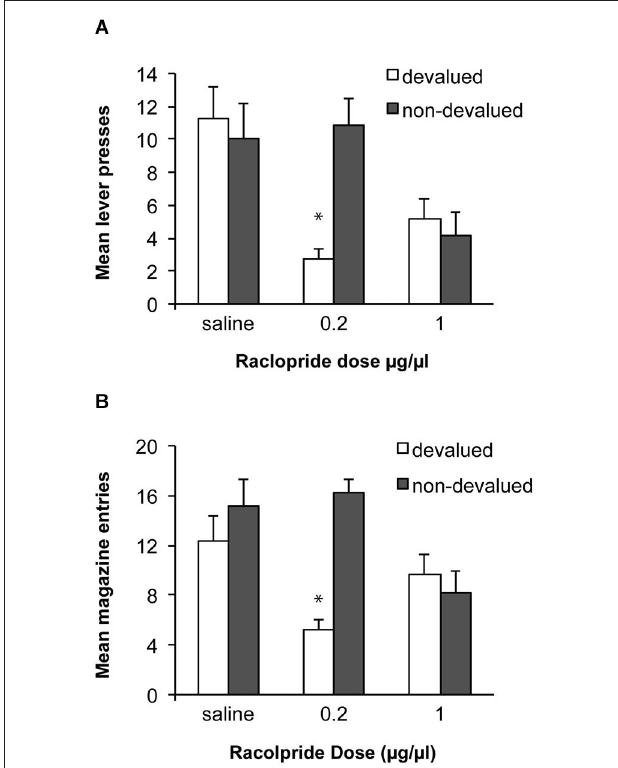
FIGURE 5 | Effects of raclopride infusion into the DLS on sensitivity to outcome devaluation . (A) Following 8 weeks of ethanol self-administration lever-press responding was insensitive to devaluation following saline infusions. Infusion of the 0.2 µ g/ µ l dose of raclopride restored sensitivity to devaluation. After infusion of the higher dose (1.0 µ g/ µ l) sensitivity to devaluation was again lost. * indicates p < 0.05. (B) Mean magazine entries during the devaluation